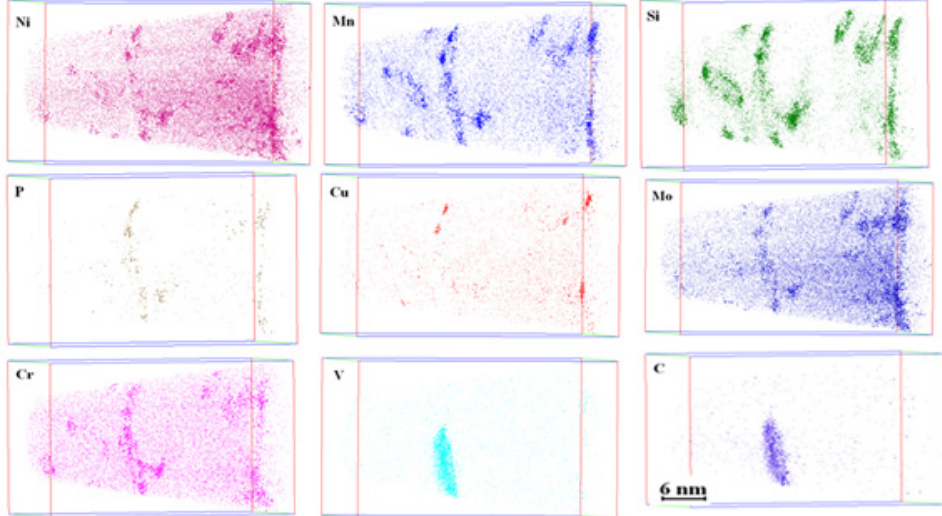
Figure 5. APFIM results of highly irradiated (6.19 × 10 20 n/cm 2 , E > 1 MeV) Cr–Mo–V steel. Stronger colors mean increased density. Cu precipitations occur first and the other elements join to it forming clusters. Vanadium carbides occurred still in the foundry, but during irradiation other alloying and polluting elements join to them. It is also can be seen that that many clusters are not Cu but Mn based.